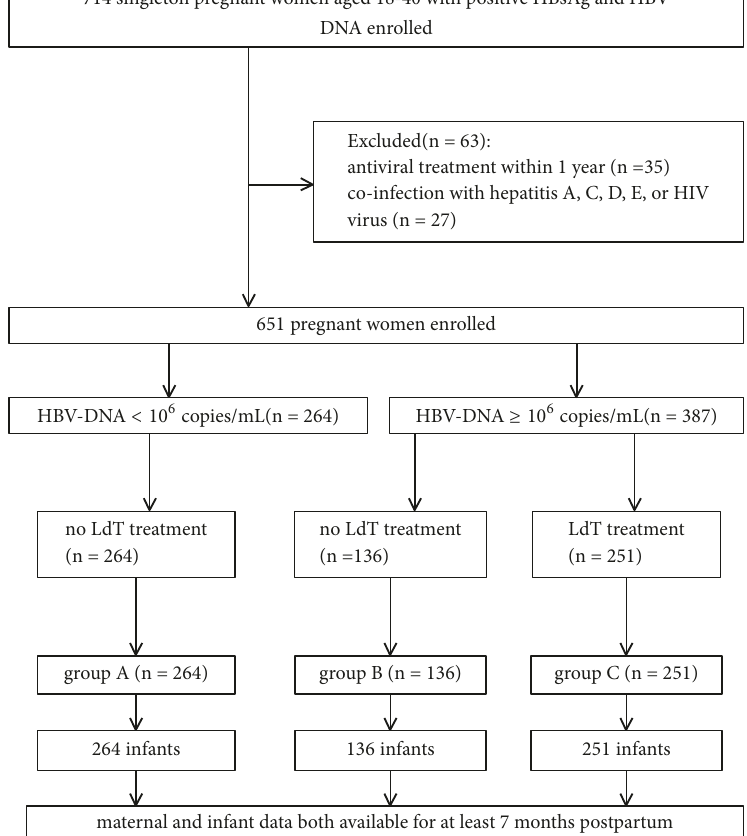
Figure 1: Flowchart of patients’ enrollment. HBV, hepatitis B virus; HBsAg, hepatitis B surface antigen; LdT,